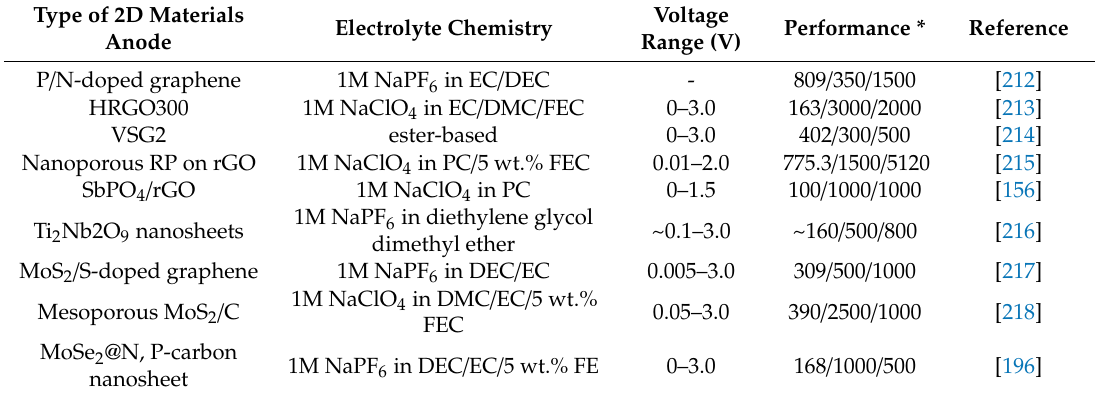
Table 4. High performance of 2D materials as anodes in Na-ion battery